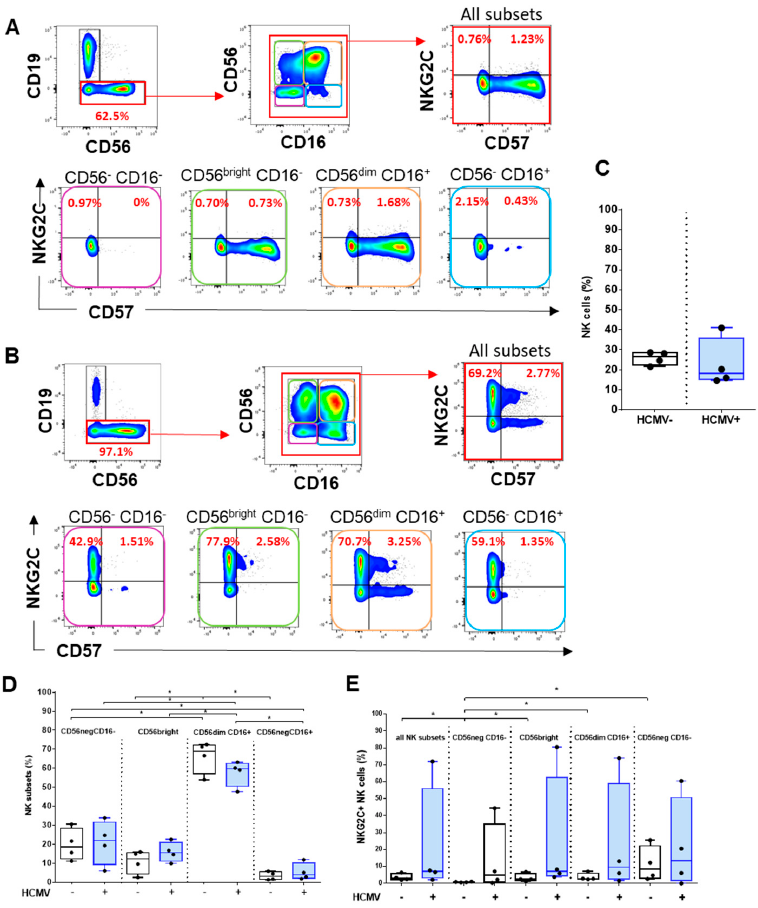
Figure 4. Analysis of HCMV-induced NK cell subsets . ( A , B ) Representative density plots showing the sequential selection (upper panel, left to right) CD3 - γδ - T cells, CD19 - cells using CD19/CD56 costaining, and CD56/CD16 costaining, enabling the determination of 4 major NK cell subsets. Co-expression for CD57/NKG2C is shown for all NK (upper panel) and for each NK subset (lower panel). The data shown are from one representative HCMV - HV ( A ) and HCMV + kidney transplant recipient ( B ). For comparison, cell frequency (%) is indicated for some costainings. Quantitative analyses are represented as box plots comparing the percentages of total NK cells ( C ), the percentages of NK subsets ( D ), and the percentages of NKG2C + NK cells ( E ) for HCMV - ( n = 4) and HCMV + ( n = 4) individuals. p value: * for p < 0.05.